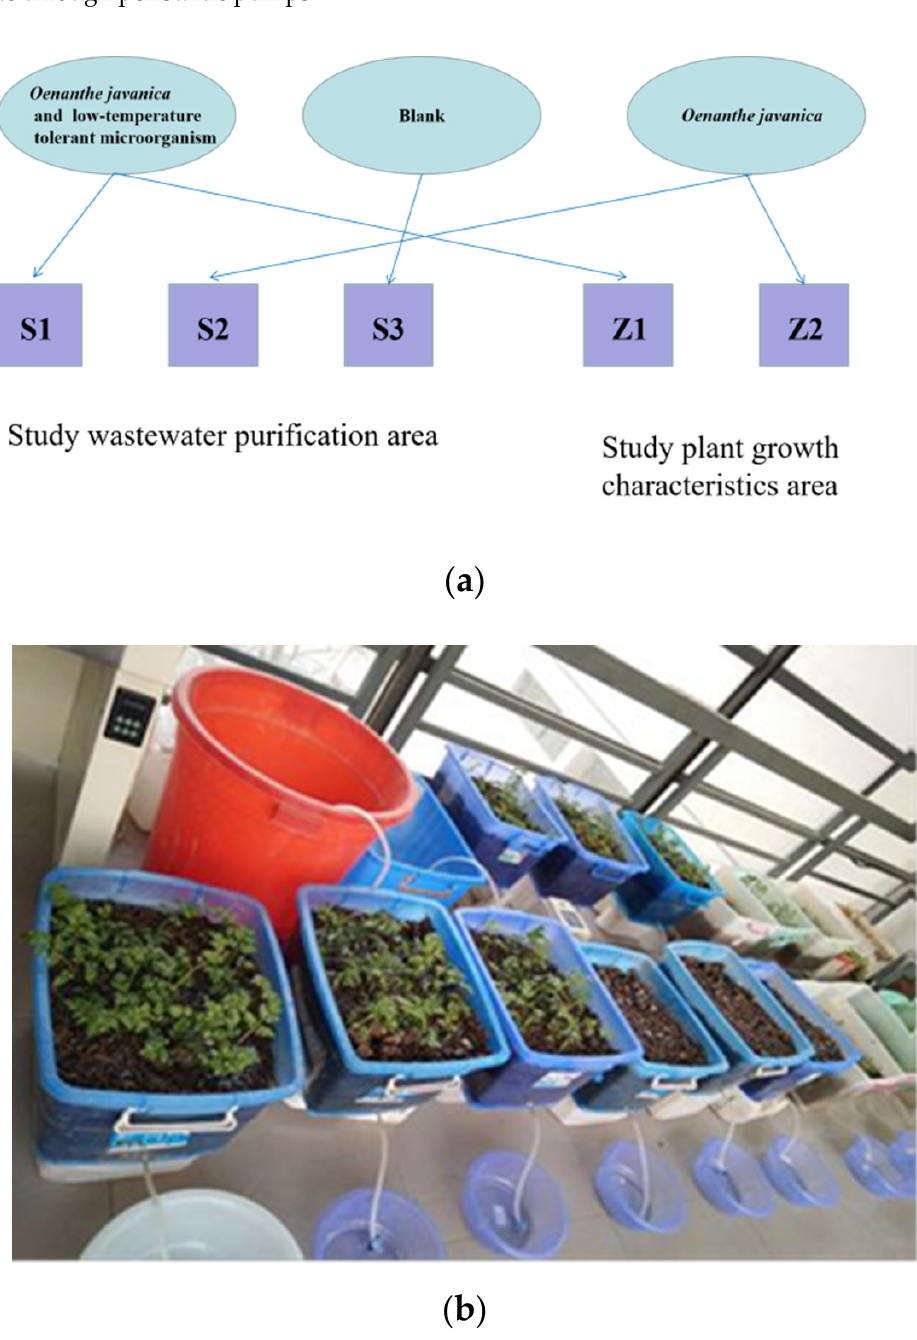
Figure 1. The general layout of the experimental facility ( a ); VSFCW treatment system ( b ).